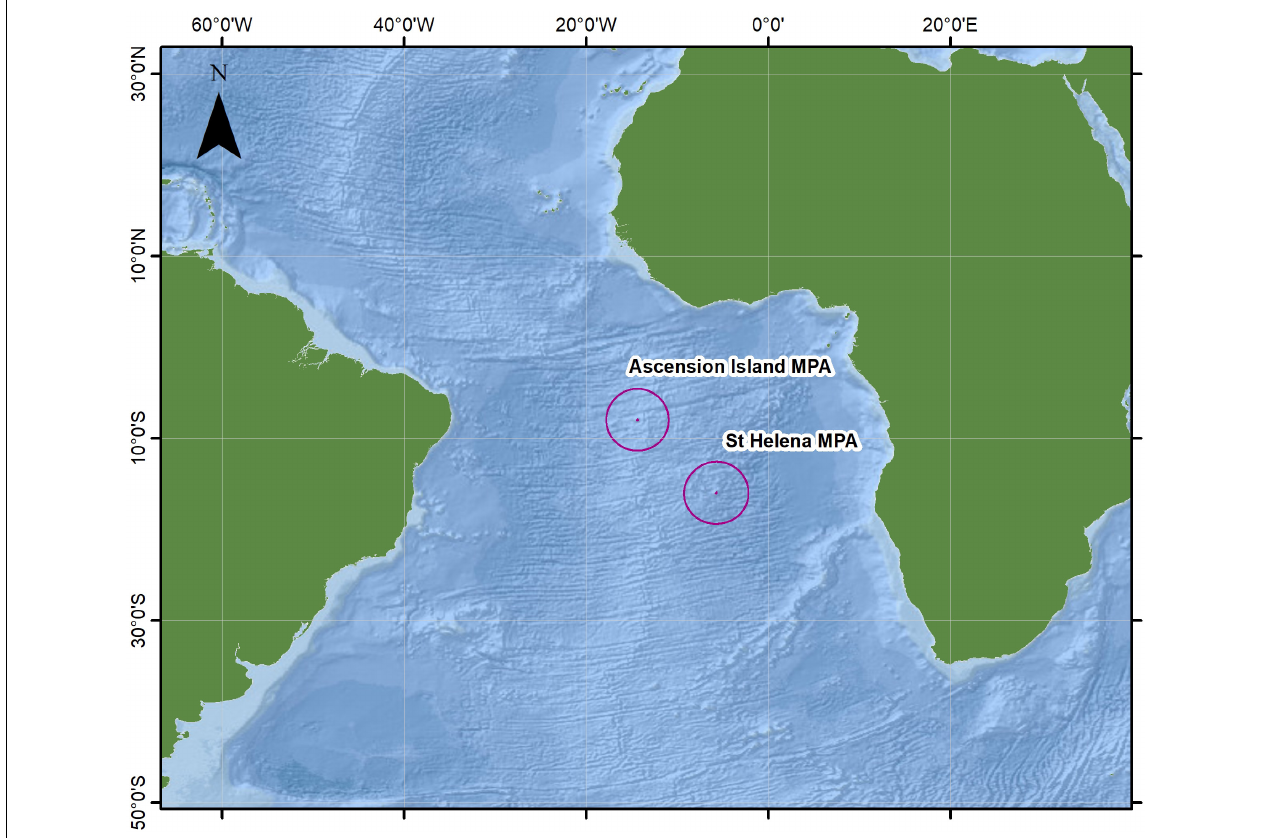
FIGURE 2 | The location of St Helena Marine Protected Area (MPA) and Ascension Island MPA in the South Atlantic Ocean. The purple circles indicate the extent of each island’s Exclusive Economic Zone. Basemap bathymetry from Esri